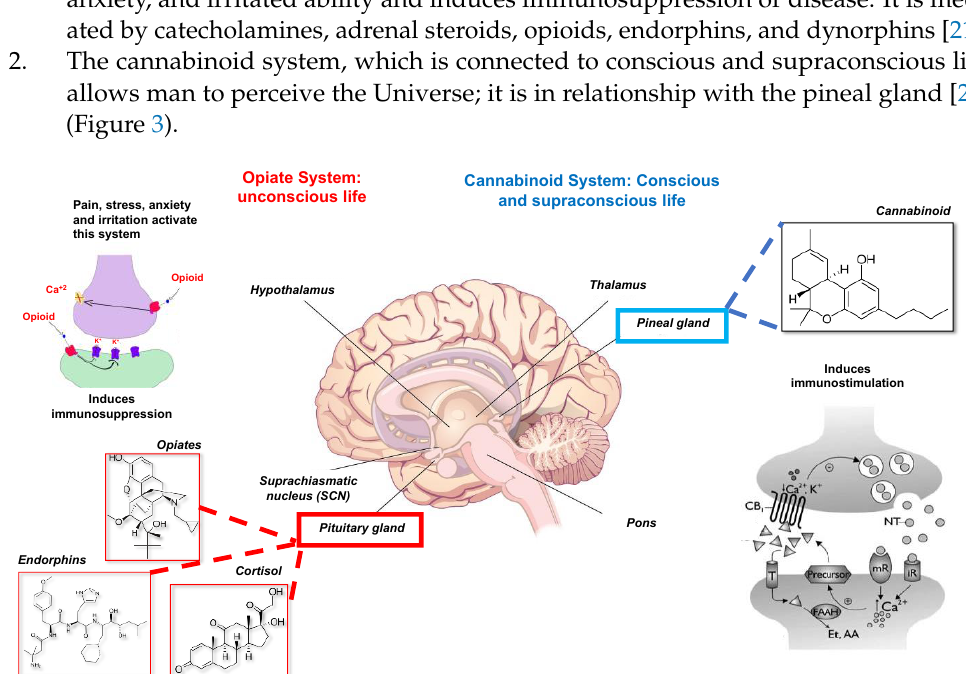
Figure 3. Opiates and cannabinoid system. The activation of the opiate system results in immuno- suppression; in contrast, the cannabinoid system results in immunostimulation. Torres-Sanchez ED modified this image, which was obtained from Creative Commons BY based on an unknown author.